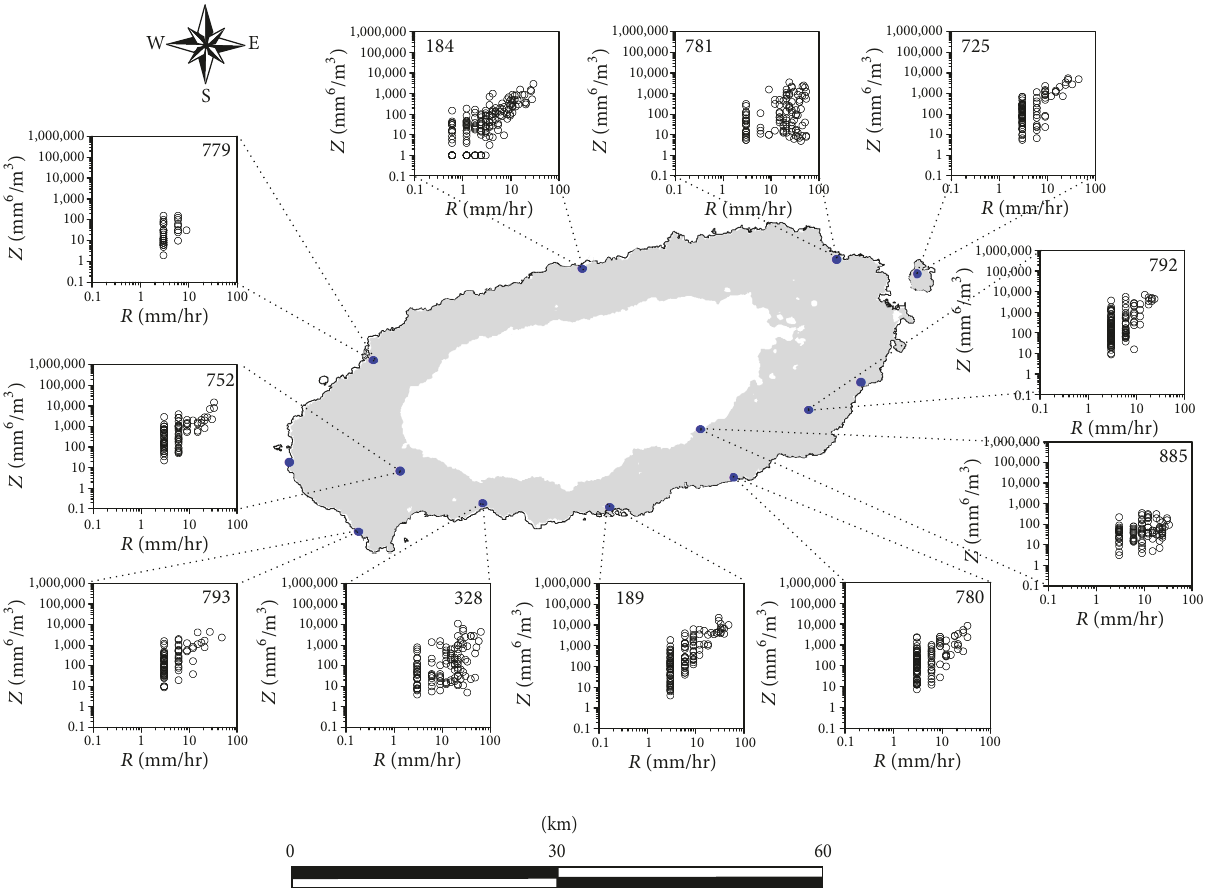
Figure 6: Scatter plots of rain gauge rain rate and radar reflectivity at AWS locations within the 0–250 m altitude zone.